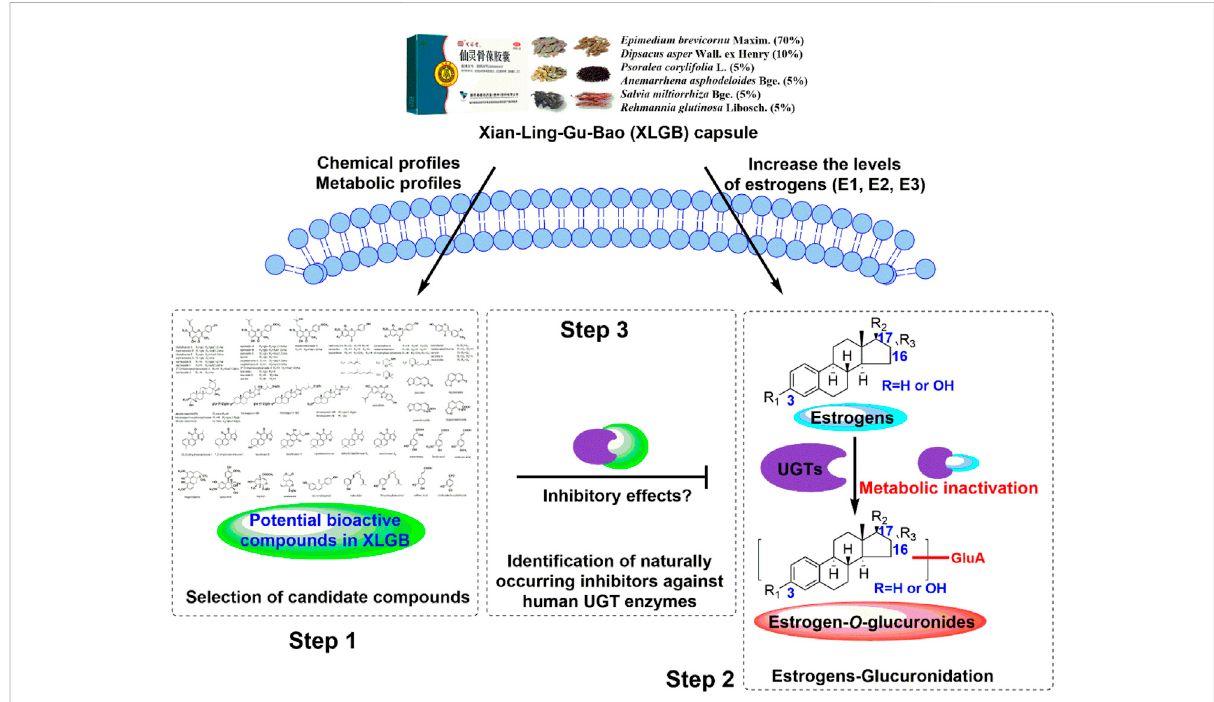
FIGURE 1 Analytical strategy for the identi fi cation of naturally occurring inhibitors against the glucuronidation of